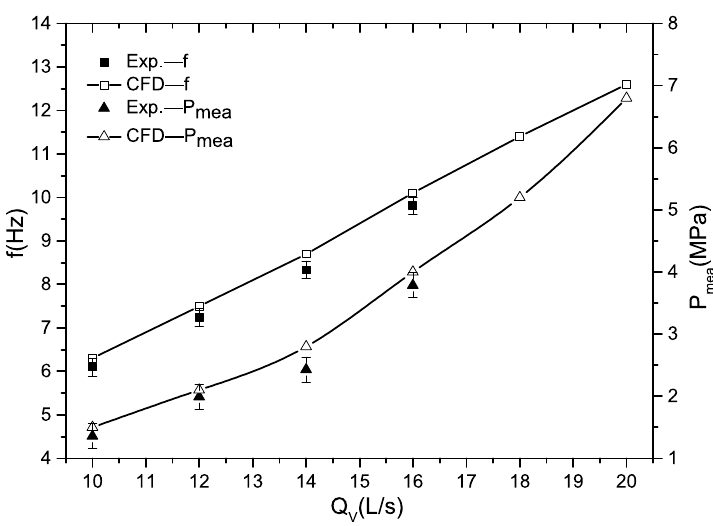
Figure 5. Comparison between experimental tests and CFD (Computational Fluid Dynamics) of mean pressure drop P mea and stroke frequency f .